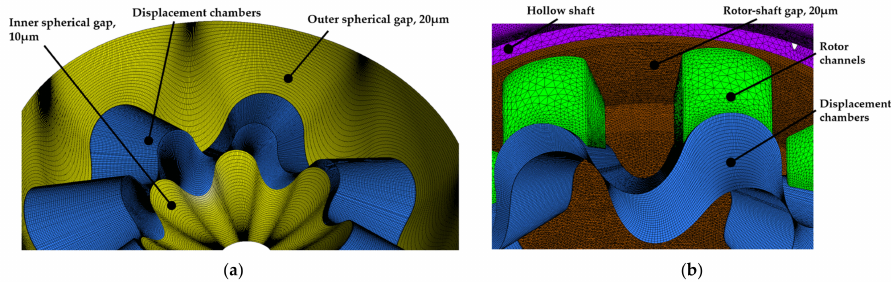
Figure 9. Meshing details of the inner and outer spherical gap ( a ) and of the rotor–shaft gap as well as of the rotor channels ( b ) of the TMC pump.